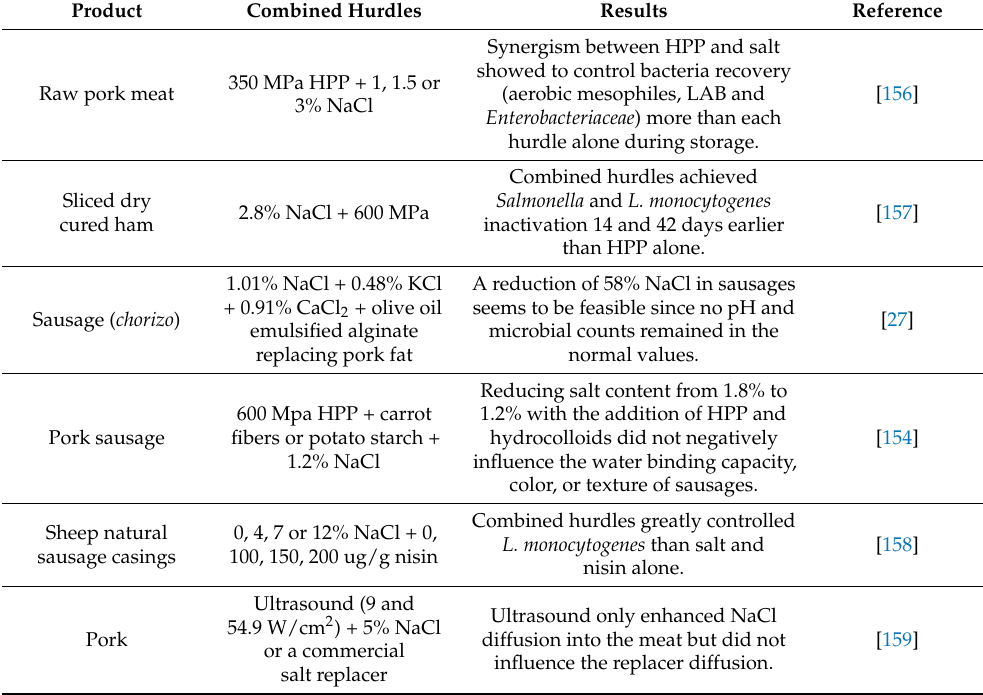
Table 3. Use of cumulative and synergistic hurdles with salt to achieve the safety and quality of meat products. Product Combined Hurdles Results